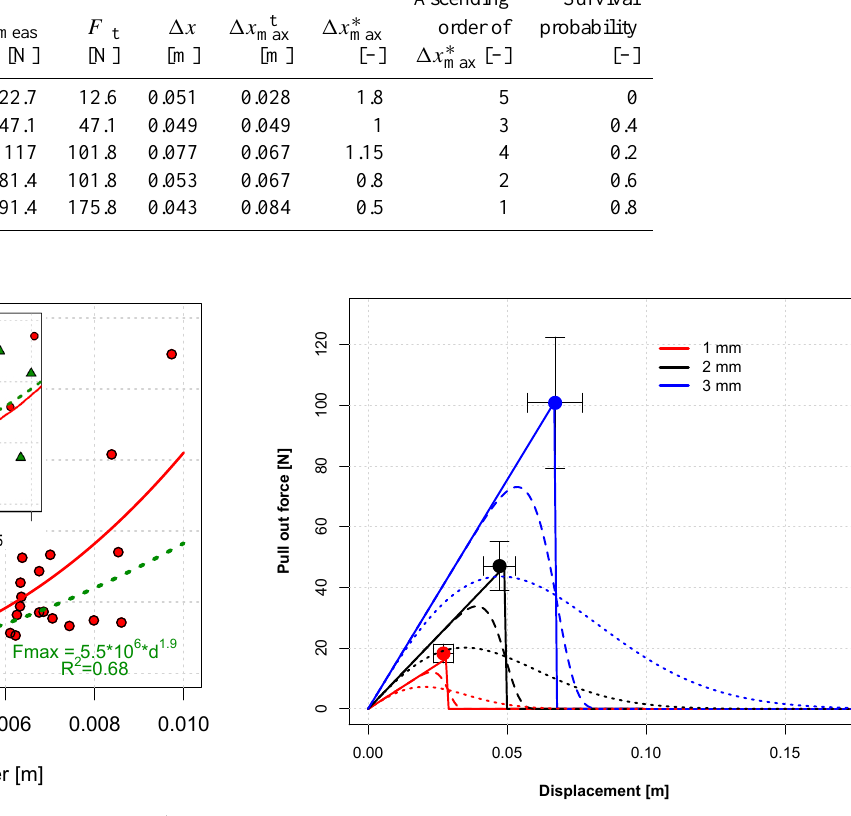
Fig. 2. Maximum measured tensile forces of Spruce roots ( Picea abies L.) as a function of root diameter. Green triangles are data from field pullout experiments (Schwarz et al., 2011) and red circles are data of laboratory tensile tests. The red line is the fit for the lab- oratory tests; the green dashed line is the fit of the field tests, extrap- olated to diameters larger than 0.004m for comparison purposes.